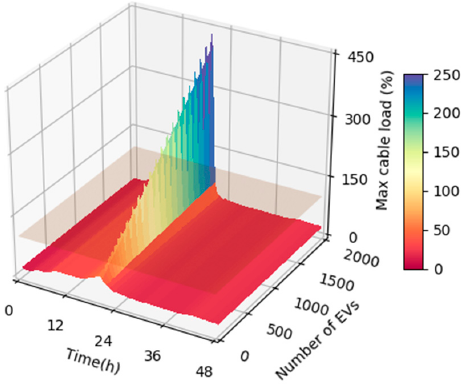
Figure 9. The maximum cable load in Scenario 2 in upper feeder for different numbers of EVs.